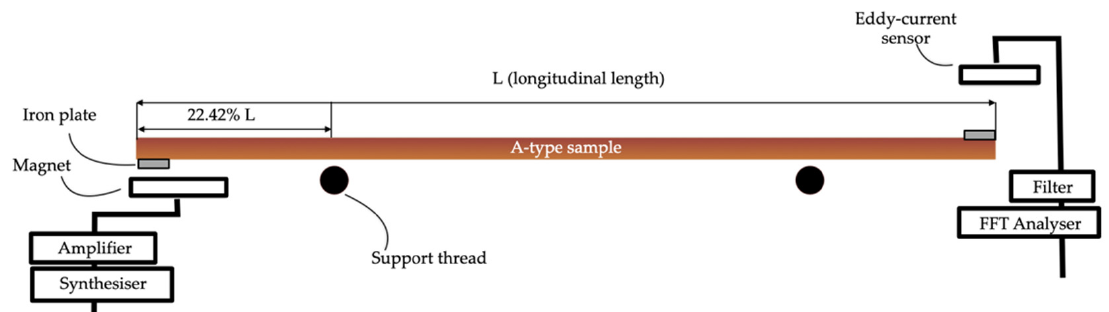
Figure 4. The measuring apparatus of the flexural vibration test.